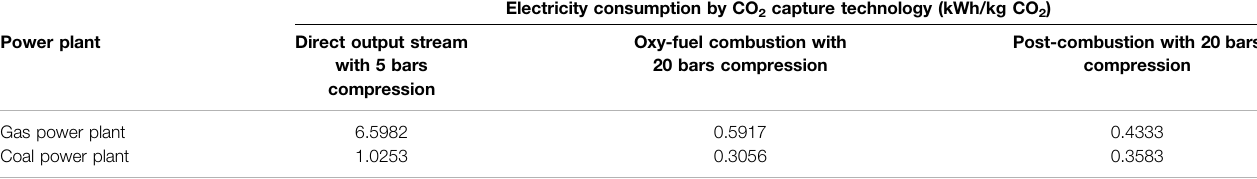
TABLE 3 | Electricity consumption of CO 2 capture & compression operation, by capture technology and power plant